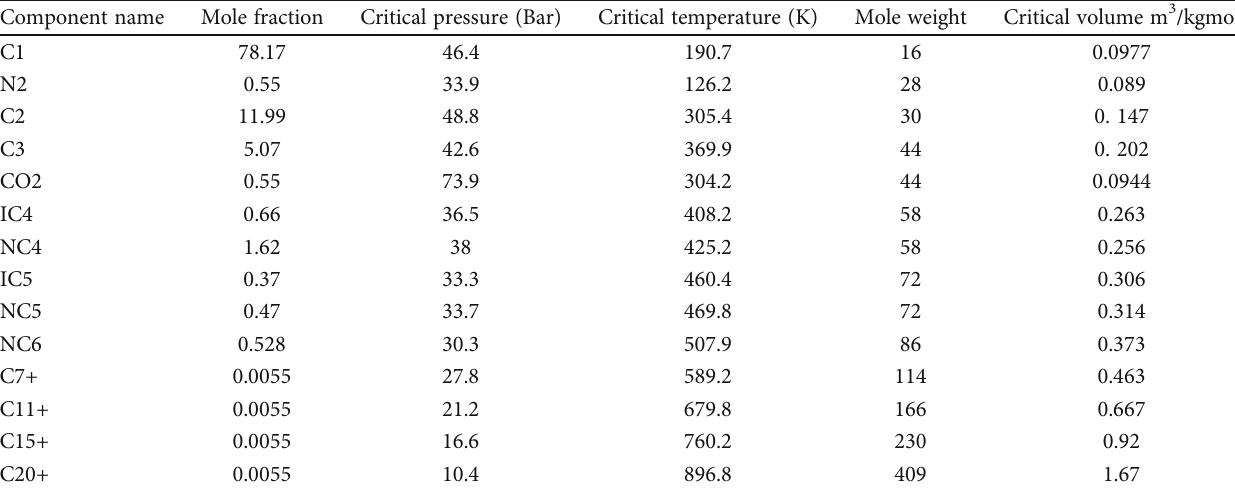
Table 3: The fl uid composition of Case